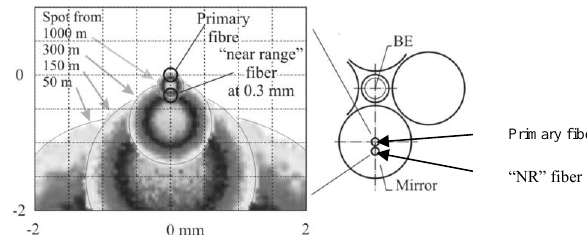
Fig. 5. Positions of the primary and NR fibers and the blur spot contours at the focal plane of a telescope mirror: left – modeled blur spot contours from different distances; right – a sketch of the receiver showing the positions of the primary and NR fibers, the beam expander (BE), and the telescope